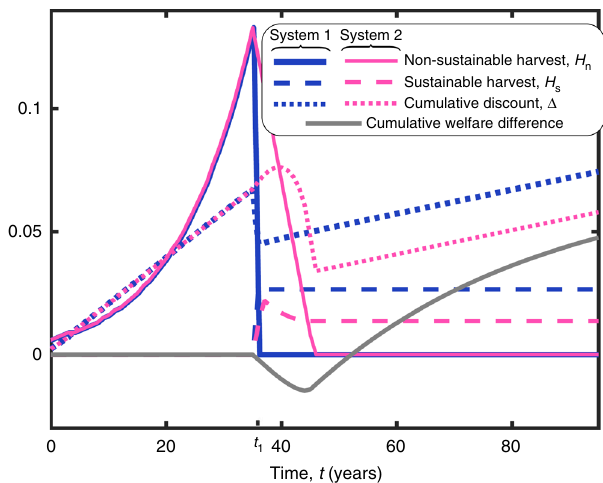
Fig. 3 Social welfare and the cumulative discount are ultimately lower if the transition to sustainable harvest is more gradual. Demonstrated are the aggregate non-sustainable harvest, H n ( t ) (solid lines); the aggregate sustainable harvest, H s ( t ) (dashed lines); and the cumulative discount, Δ (dotted lines), for two systems. System 1 (blue) follows the market solution, in which society abruptly stops harvesting non-sustainably at t = t 1 . System 2 (purple) follows the same dynamics until t = t 1 , but then, society gradually shifts to sustainable harvest. The gradual transition postpones the decline in the cumulative discount, but ultimately, it declines to an even lower value than its value in system 1. Moreover, the cumulative welfare, U t , in system 1 is initially smaller, but it ultimately becomes greater compared to system 2 (gray). Harvest rates are given in units of (years) − 1 , and Δ is given by 100 times the value on the y -axis. The parameters are the same as in Fig. 2c (Parameter values and Source data are provided as a Source Data fi